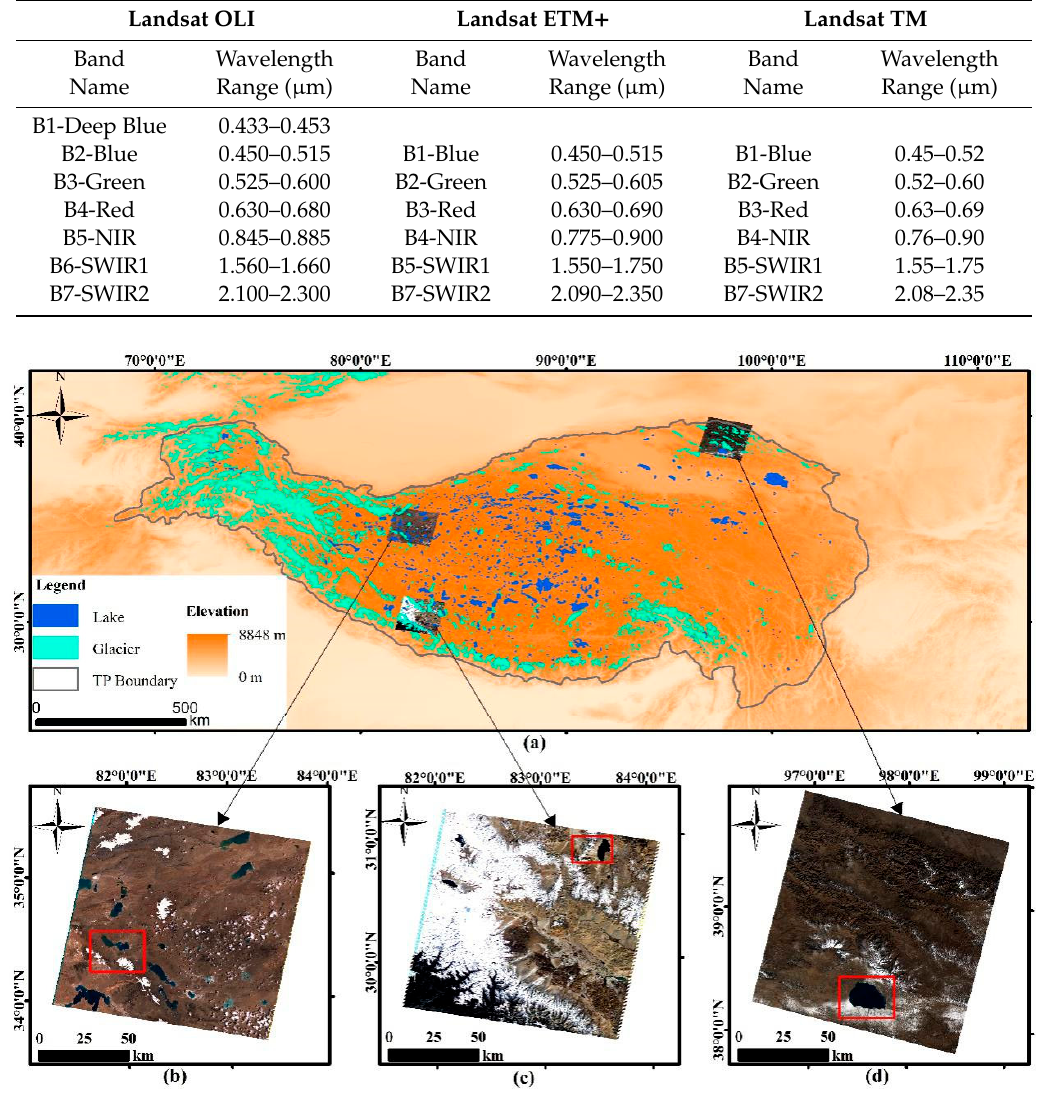
Figure 2. ( a ) the Tibetan Plateau; ( b ) Landsat-7 ETM+ image (RGB:321; Region II); ( c ) Landsat-5 TM image (RGB:321; Region III); ( d ) Landsat-8 OLI image (RGB:432; Region I).